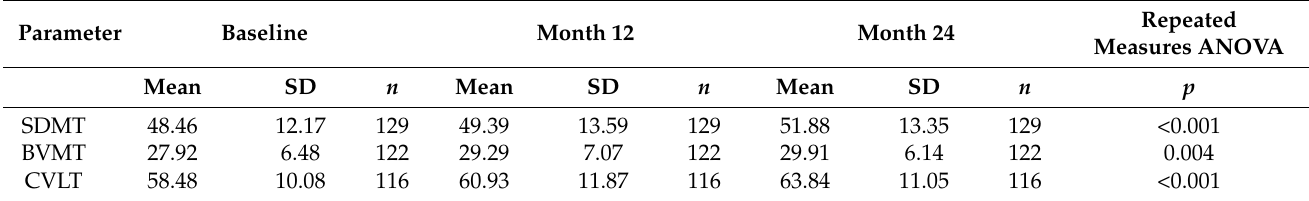
Table 3. BICAMS outcomes.